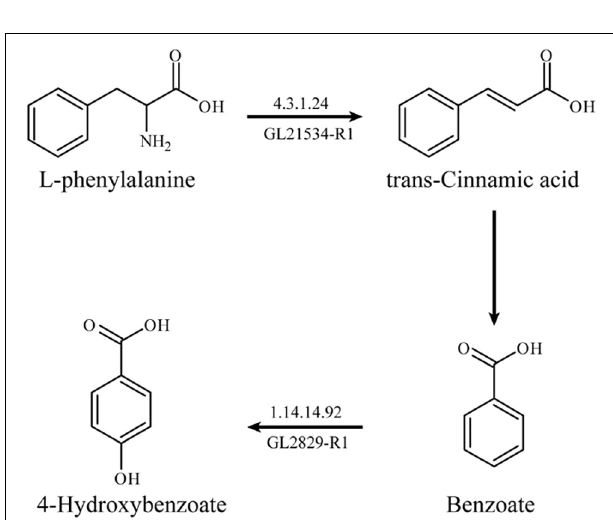
FIGURE 4 | The metabolic pathway of L-phenylalanine in G. lucidum.